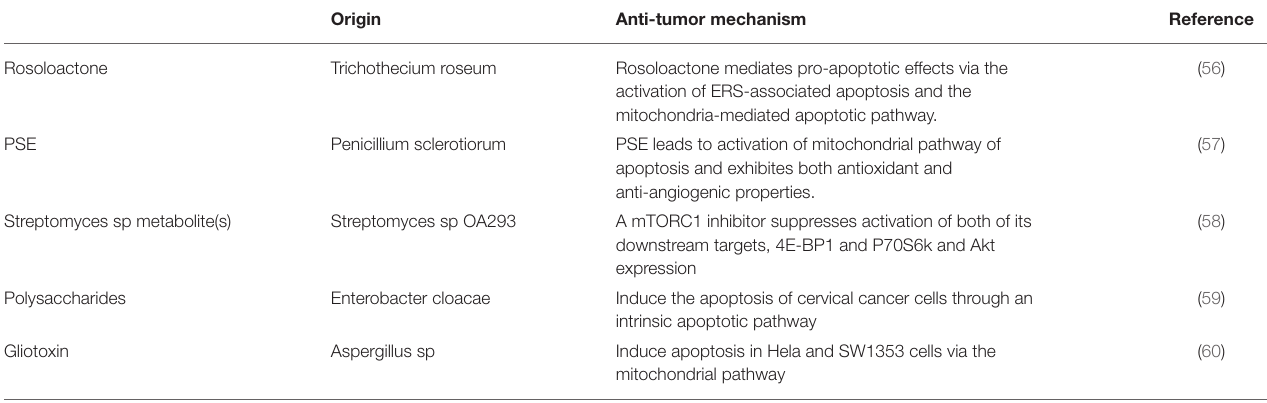
TABLE 4 | Characteristics of the secondary metabolites derived from microorganisms used for cervical cancer